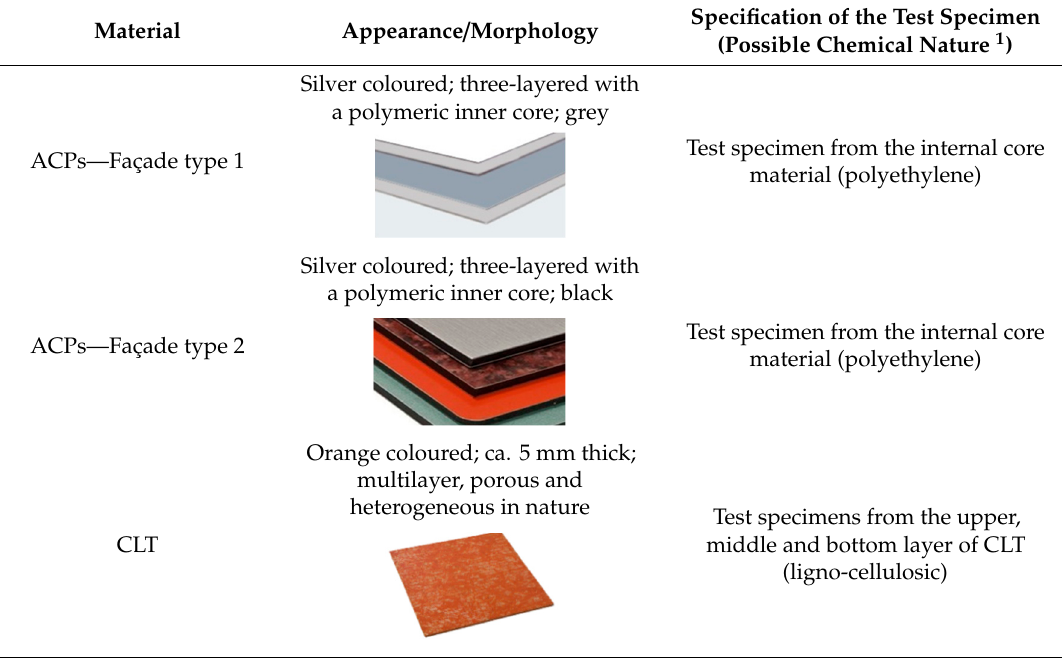
Table 1. Details of the tested materials.